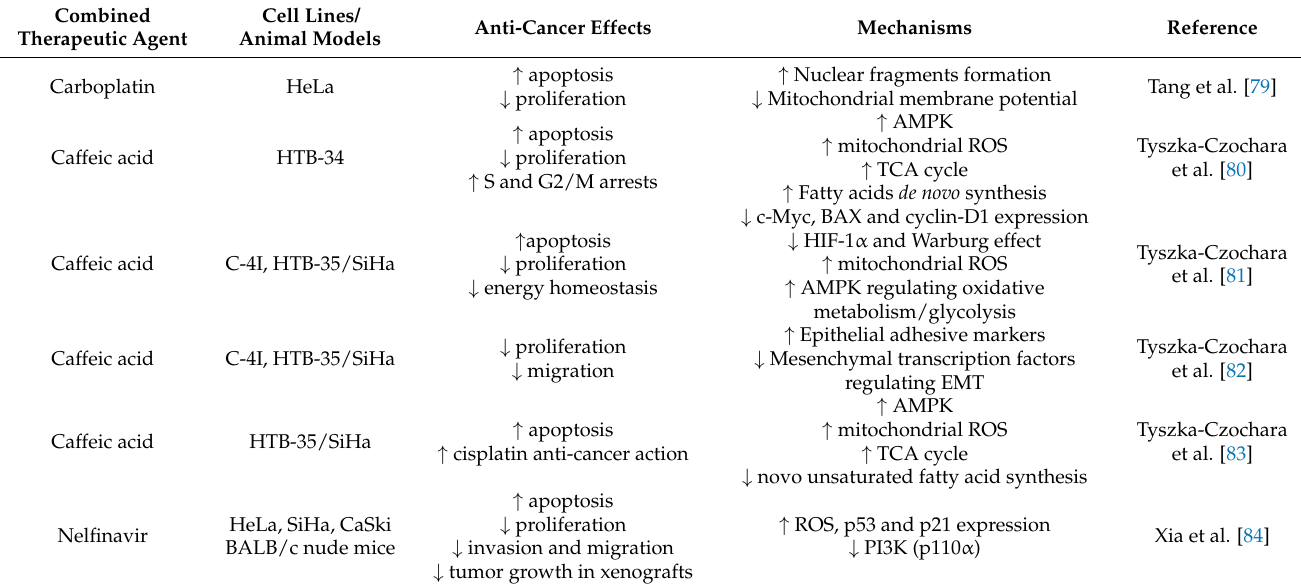
Table 2. Metformin in combination with therapeutic agents exhibiting anti-cervical cancer